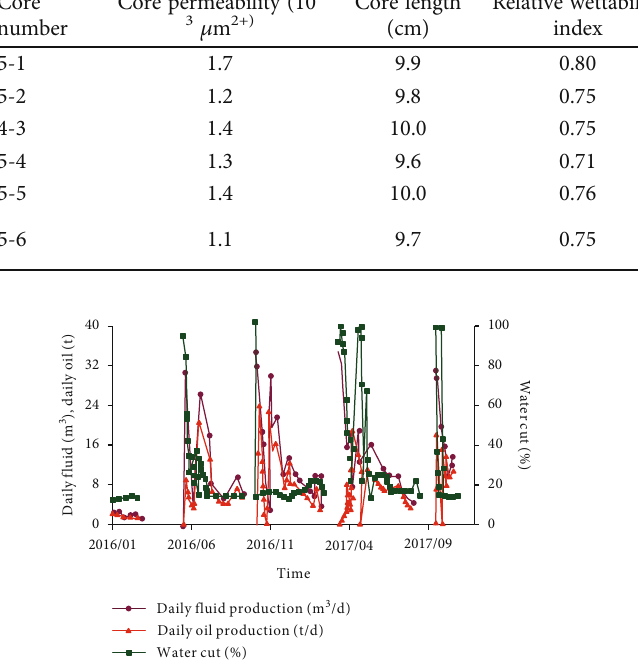
Figure 4: Production curve of water hu ff -n-pu ff during the four rounds in typical